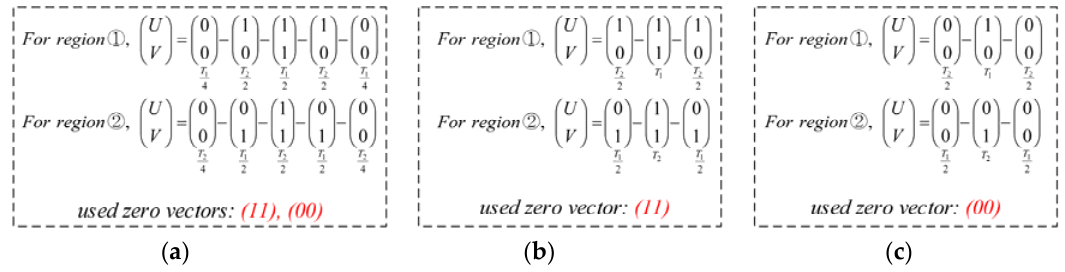
Figure 5. Typical switching patterns according to the utilization of zero vectors: ( a ) two zero vectors are used, ( b ) only (11) zero vector is used in UCM, and ( c ) only (00) zero vector is used in LCM.